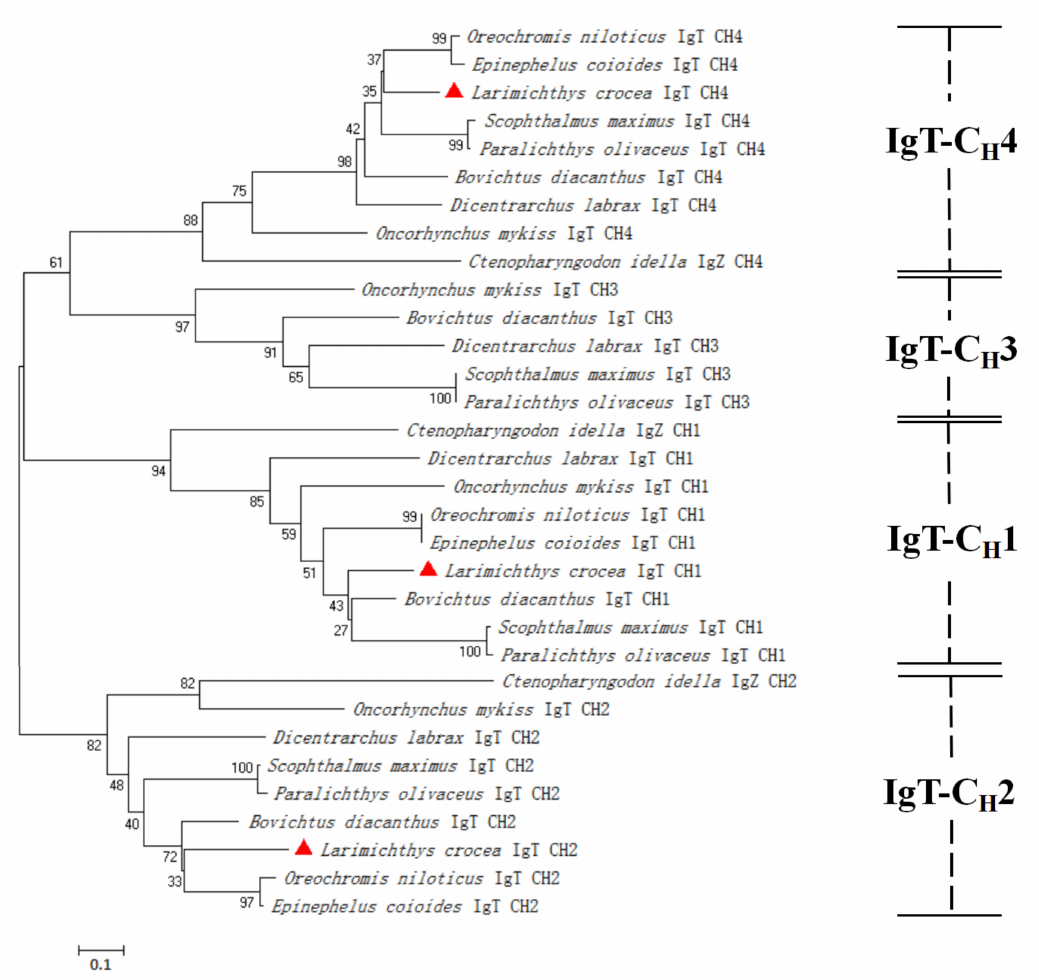
Figure 3. Phylogenetic tree of each constant domain of fish IgT heavy chains. A polygenetic tree was constructed to show the genetic relationship of each constant domain of IgT heavy chains from large yellow croakers and other fish species. The tree was constructed by MEGA software using the Neighbor Joining (NJ) method, and the numbers on nodes represent the frequency with which this node is recovered per 100 bootstrap replications in a total of 1000. The single constant domain of large yellow croaker IgT was marked with a solid red